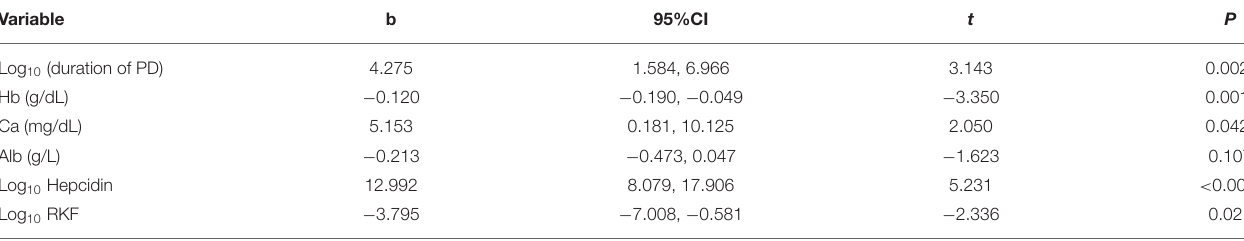
TABLE 5 | Multivariate linear regression analysis of factors associated with the IRLS score in patients undergoing PD. Variable